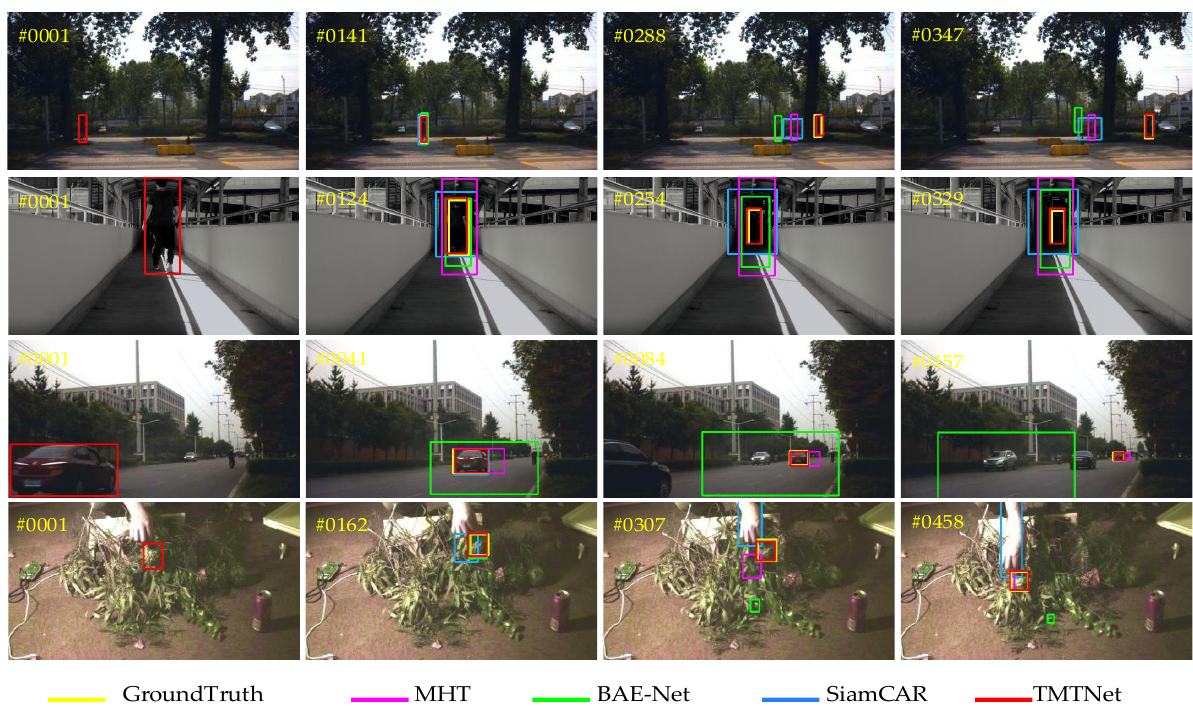
Figure 11. Qualitative result comparison of some trackers on sequences of pedestrian2, student, car3, and